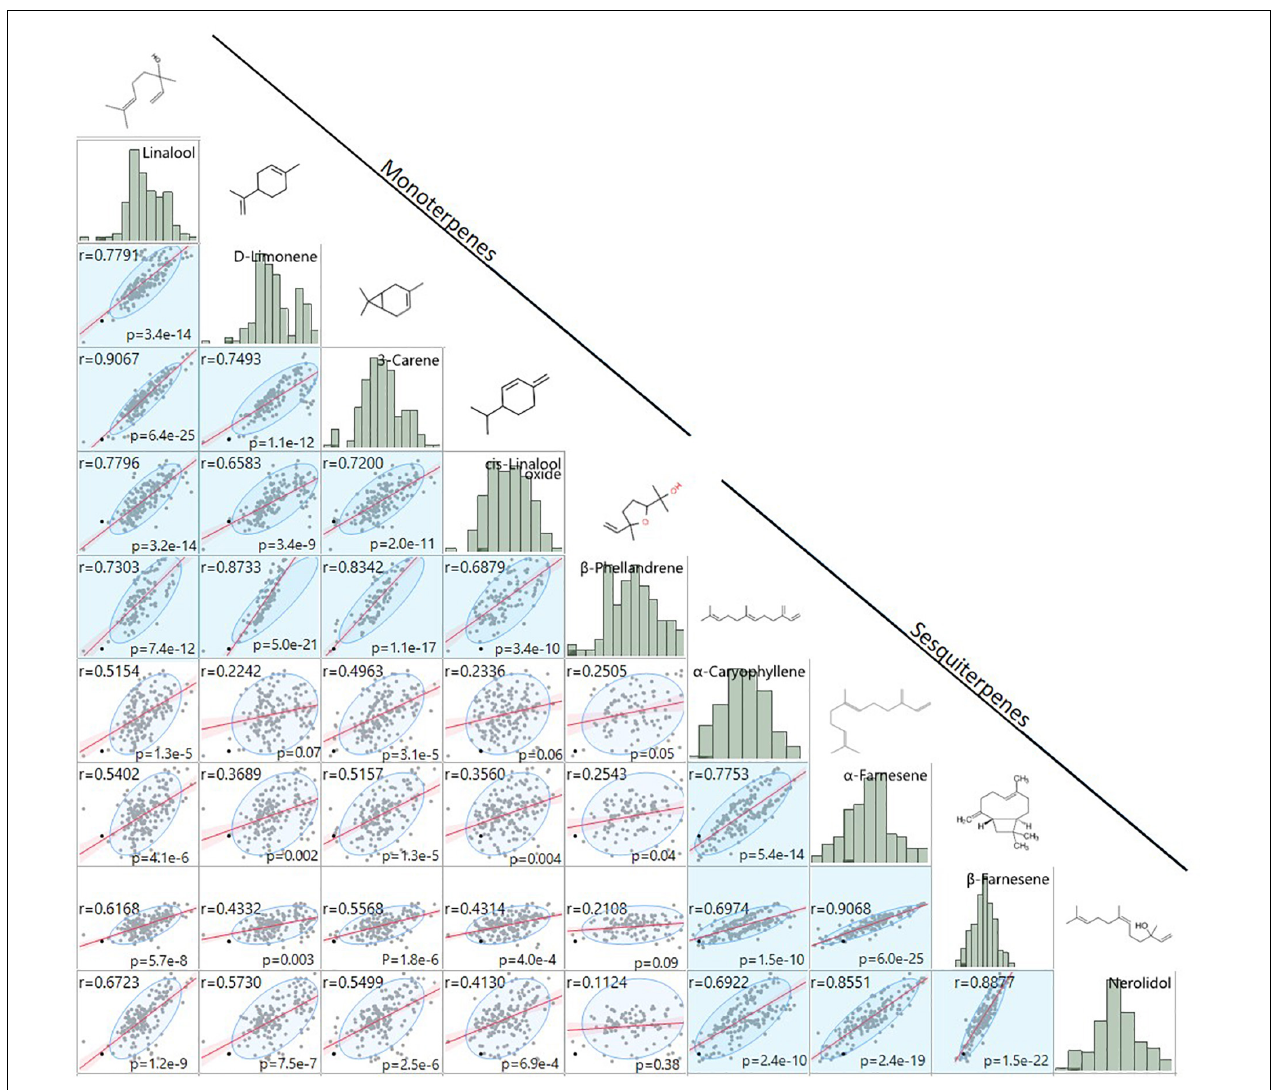
FIGURE 5 | Comparison of terpene fruit volatile abundances. Mono- and sesquiterpene volatile abundances are strongly positively correlated within group (blue shade) and less strongly positively correlated between groups (white shade). Regression statistics are shown for each pairwise comparison. Histograms of log 2 -transformed GC/MS relative abundance values and chemical structures are denoted above each